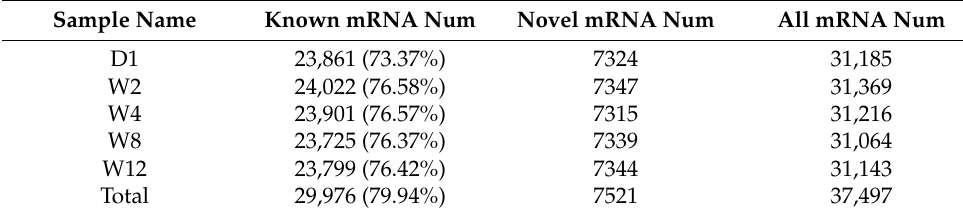
Table 2. Statistics of known and novel transcripts in each